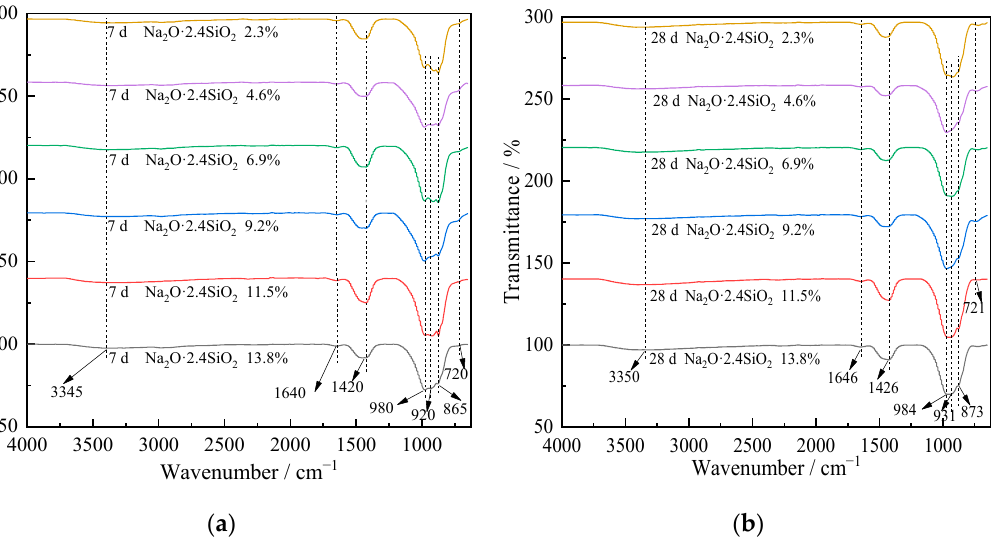
Figure 4. FTIR spectroscopy of composite alkali-activated cementitious materials. ( a ) FTIR spectroscopy after curing for 7 days ( b ) FTIR spectroscopy after curing for 28 days. Table 3. Various absorption bands corresponding with chemical group vibrations